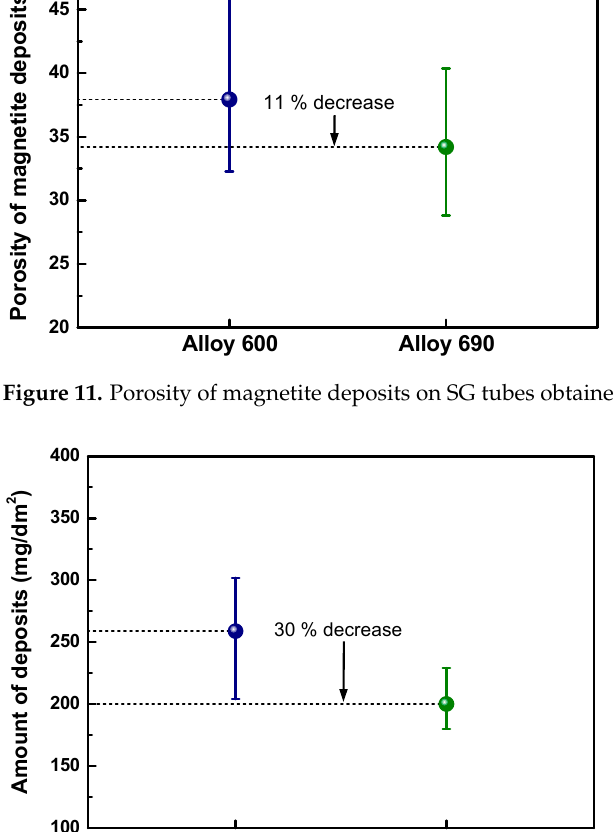
Figure 11. Porosity of magnetite deposits on SG tubes obtained using an image analyzer.